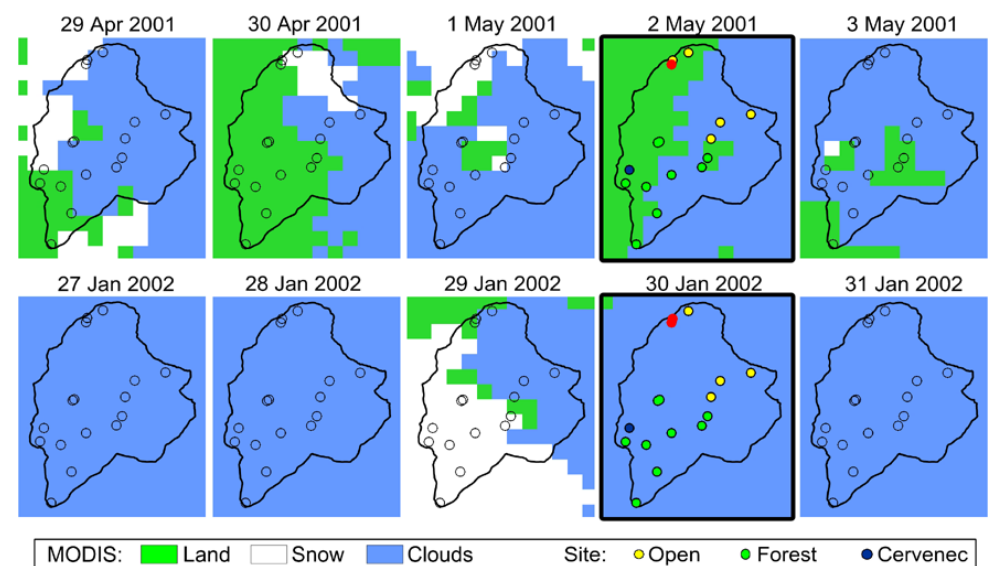
Fig. 5. Misclassification of snow as land by the combined MODIS product (top panels, May 2001) and the 2-day filter of the combined product (bottom panels, January 2002) at open sites (Fig. 4). The maps in black frames show the date of ground snow measurement; red circles indicate the sites where misclassification